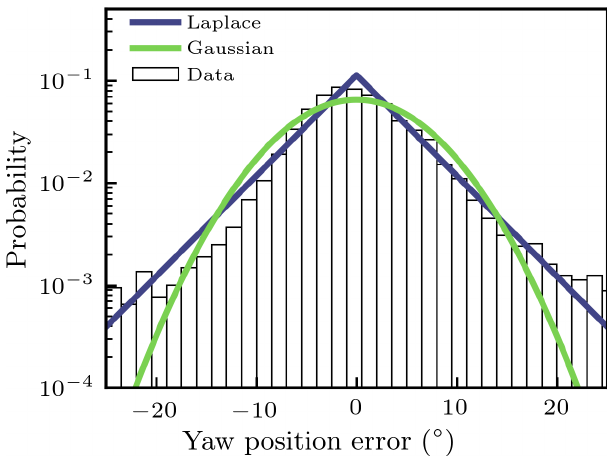
Figure 2. Errors in the yaw position, y , for a test turbine at the National Wind Technology Center at NREL (Fleming et al., 2018; Annoni et al., 2018; Damiani et al., 2018). Measurement data used to calculate the probability distribution were sampled every 30s. The solid blue and green lines show Laplace and Gaussian distribu- tions, respectively. The empirical probability mass function found from the observed yaw errors is shown with white